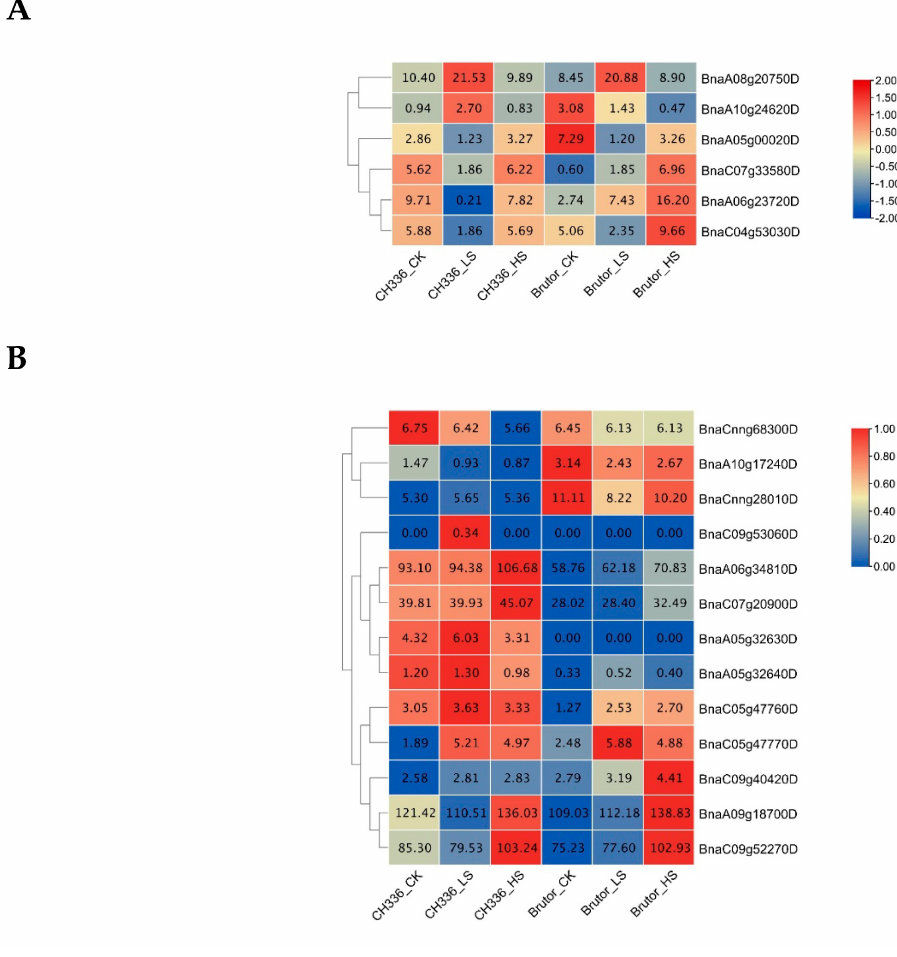
Figure 4. FPKM( − normalized heatmaps of some candidate di ff erentially expressed genes (DEGs) potentially involved in stimulating the seedling growth under moderate salinity stress in Brassica napus . ( A ). Six DEGs commonly shared between LS/CK and LS/HS and with similar expression pat- terns in two oilseed rape varieties (CH336 and Brutor). ( B ). 13 B. napus DELLA family genes. ( C ). 10 B. napus MYB46 genes. Due to the importance of the DELLA family genes, which are widely involved in var- ious important processes of plant growth and development [40], the relevant 13 B. napus